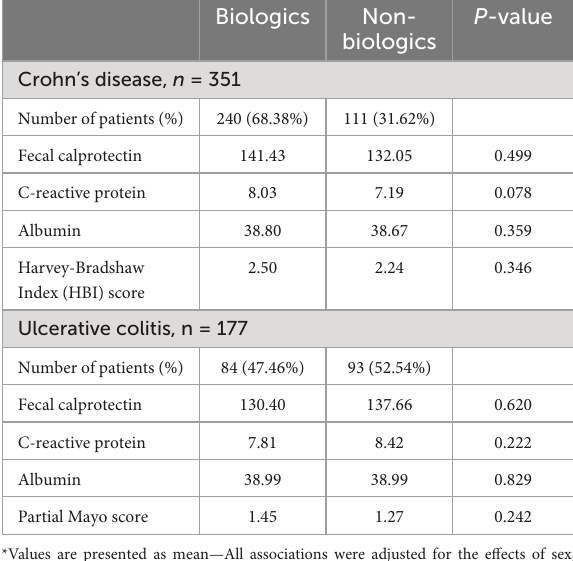
TABLE 2 T -test for the mean baseline levels of inflammatory markers and clinical scores between patients with Crohn’s disease or ulcerative colitis who are on biologics vs. non-biologics.